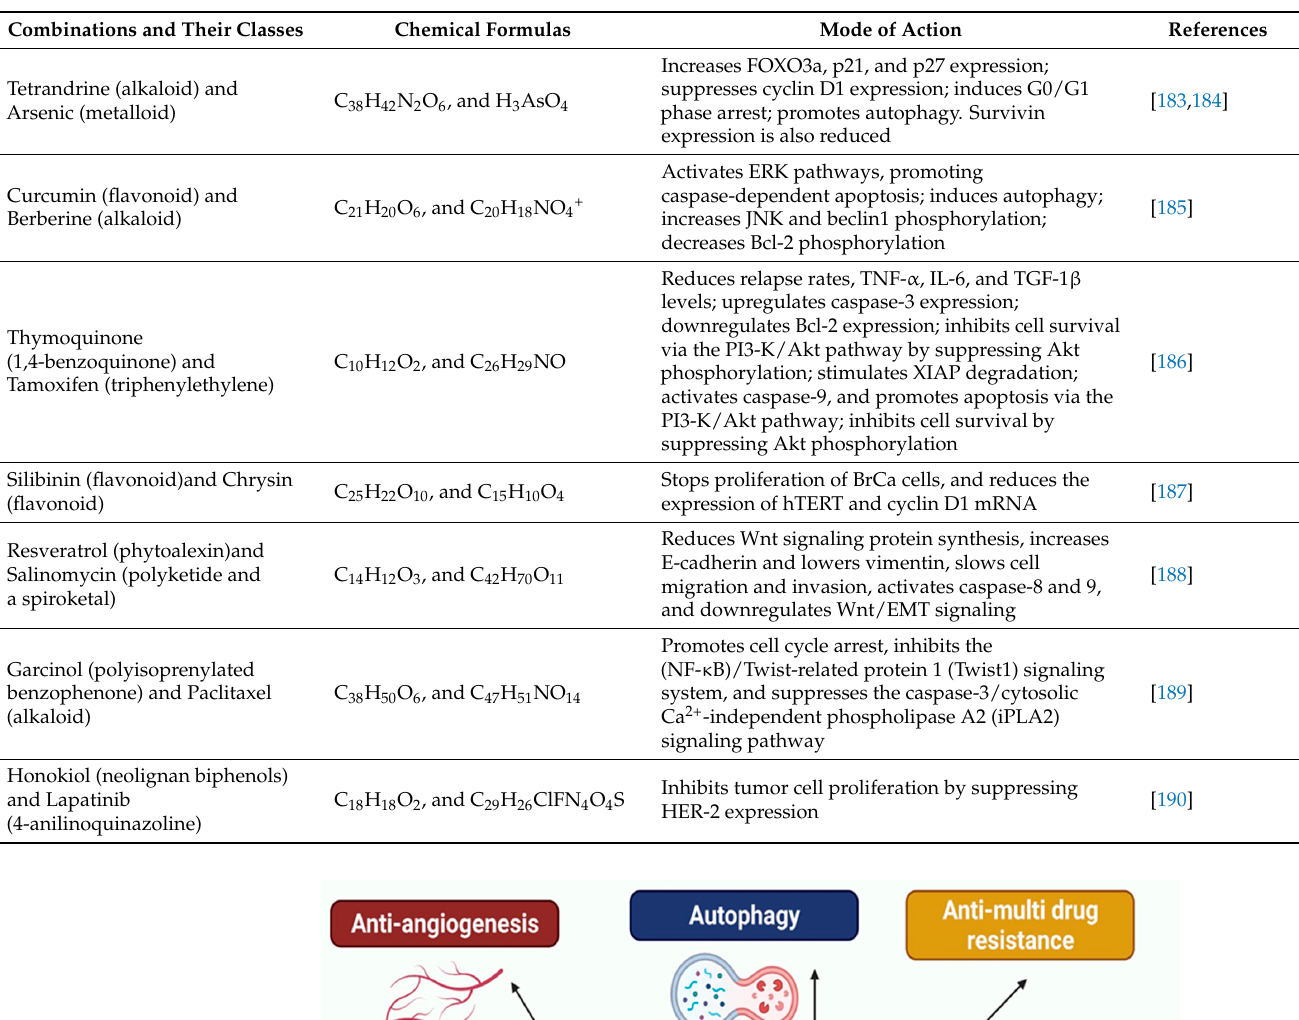
Table 2. Natural chemical combinations used for BrCa therapy and their mode of action.